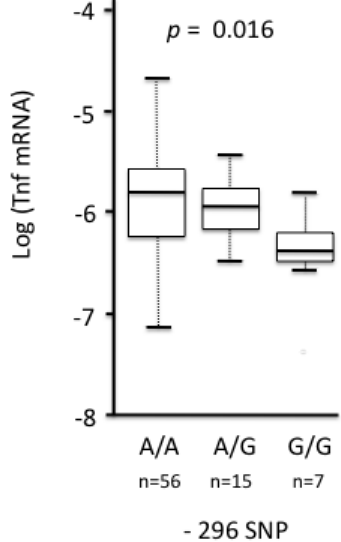
Figure 2. Relationship between variation at position − 296 of the Tnf promoter and the log-transformed relative expression of Tnf (here: log ( Tnf mRNA)) in European bank voles. Relative expression was estimated as [(E + 1) CpTar ]/[(E + 1) CpRef ] with E , E , Cp Tar Ref Tar Ref Tar and Cp being, respectively, the average efficiencies of the target (Tnf) and reference Ref (β-actin) genes and the crossing points of the target and reference genes (see [104]). ANOVA was first performed and emphasized significant differences of Tnf relative expression among Tnf promoter genotypes (ANOVA, F = 4.002, p = 0.022). Further 2,75 Tukey-Kramer tests showed that voles with genotype -296 A/A exhibited a significantly higher relative expression of Tnf than those with − 296 G/G genotype (Tukey–Kramer test, p = 0.016). Boxes represent the first and third quartiles of the distribution. Horizontal black lines correspond to medians. The vertical dashed lines correspond to 1.5 times the interquartile